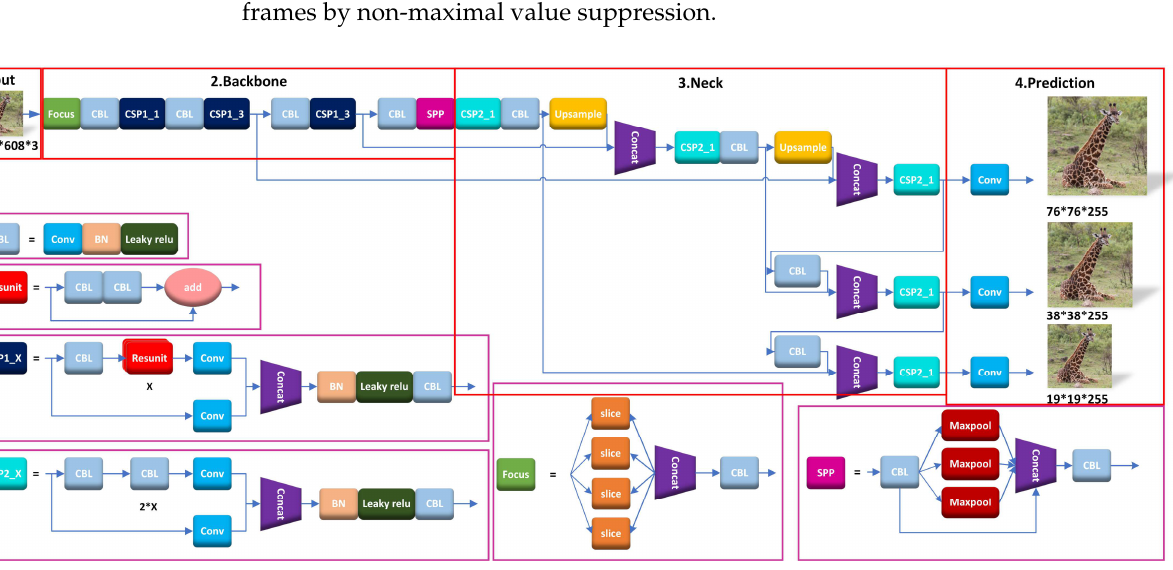
Figure 1. YOLOv5 network structure.